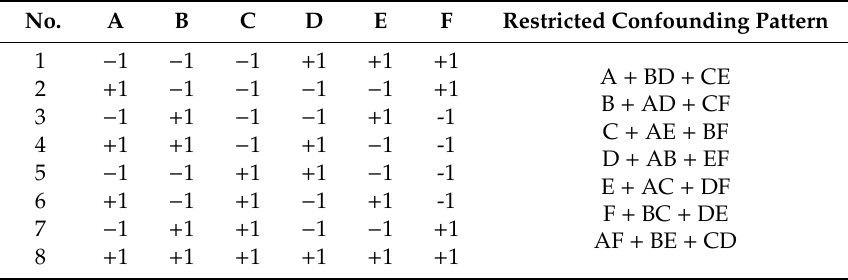
Table 3. Array of Experiments. The samples corresponding to each experiment were prepared by placing the analysis factors at the levels indicated in this